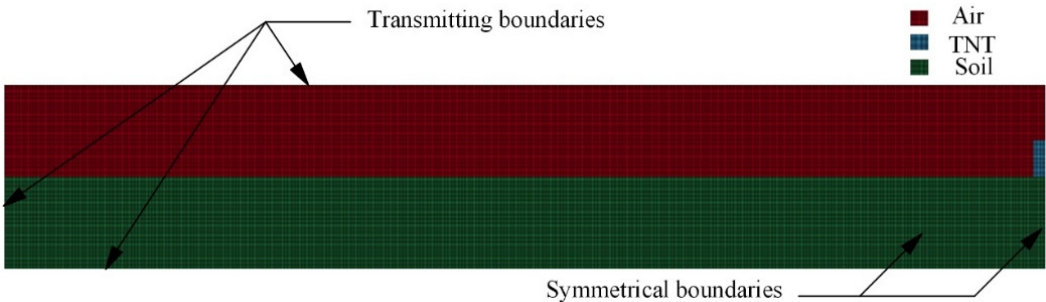
Figure 10. Boundaries of the simulated model.